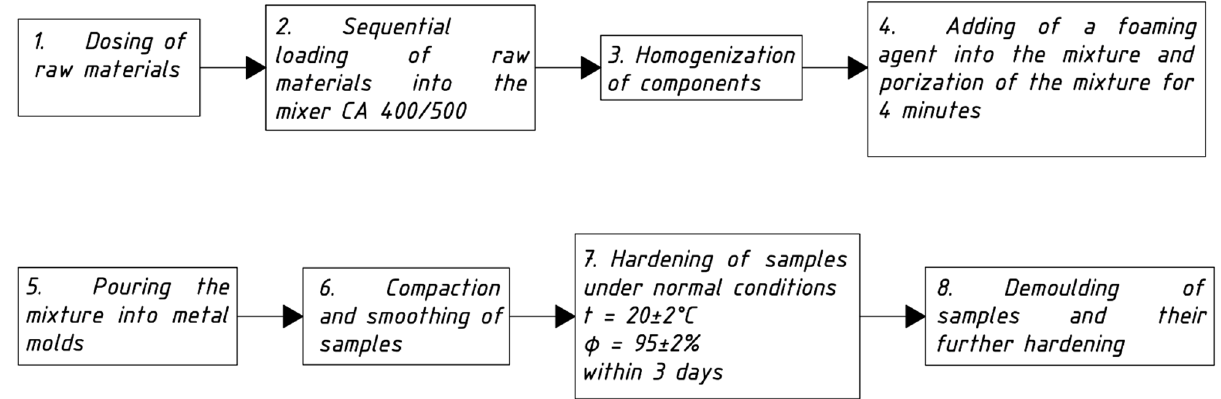
Figure 2. The process of manufacturing experimental samples.